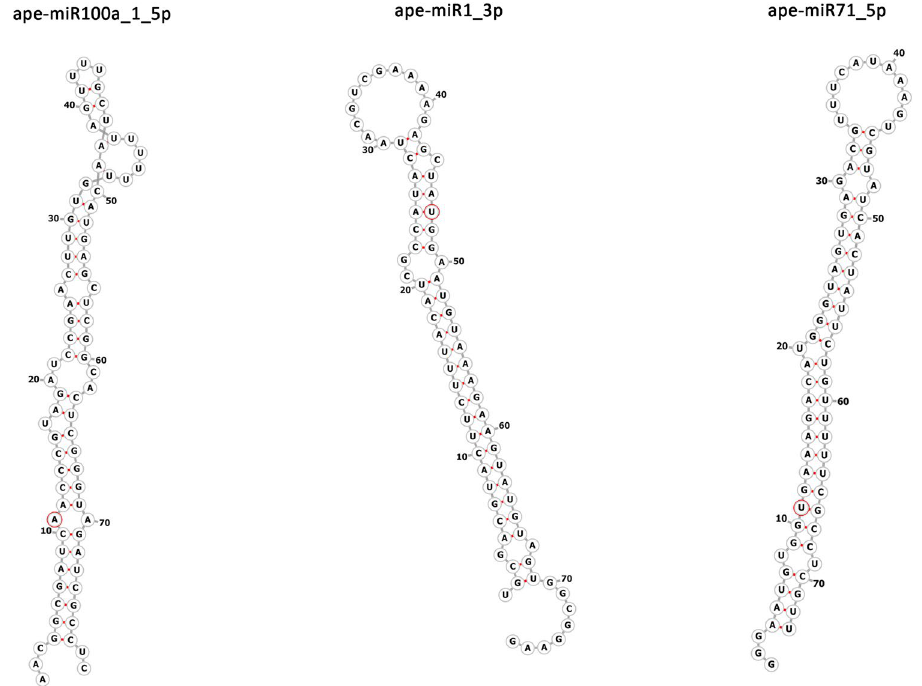
Figure 3. Secondary structures of the three most abundant miRNAs observed in the infective third stage larvae of A. pegreffii with the first nucleotide of matures sequence indicated in red, according to RNA